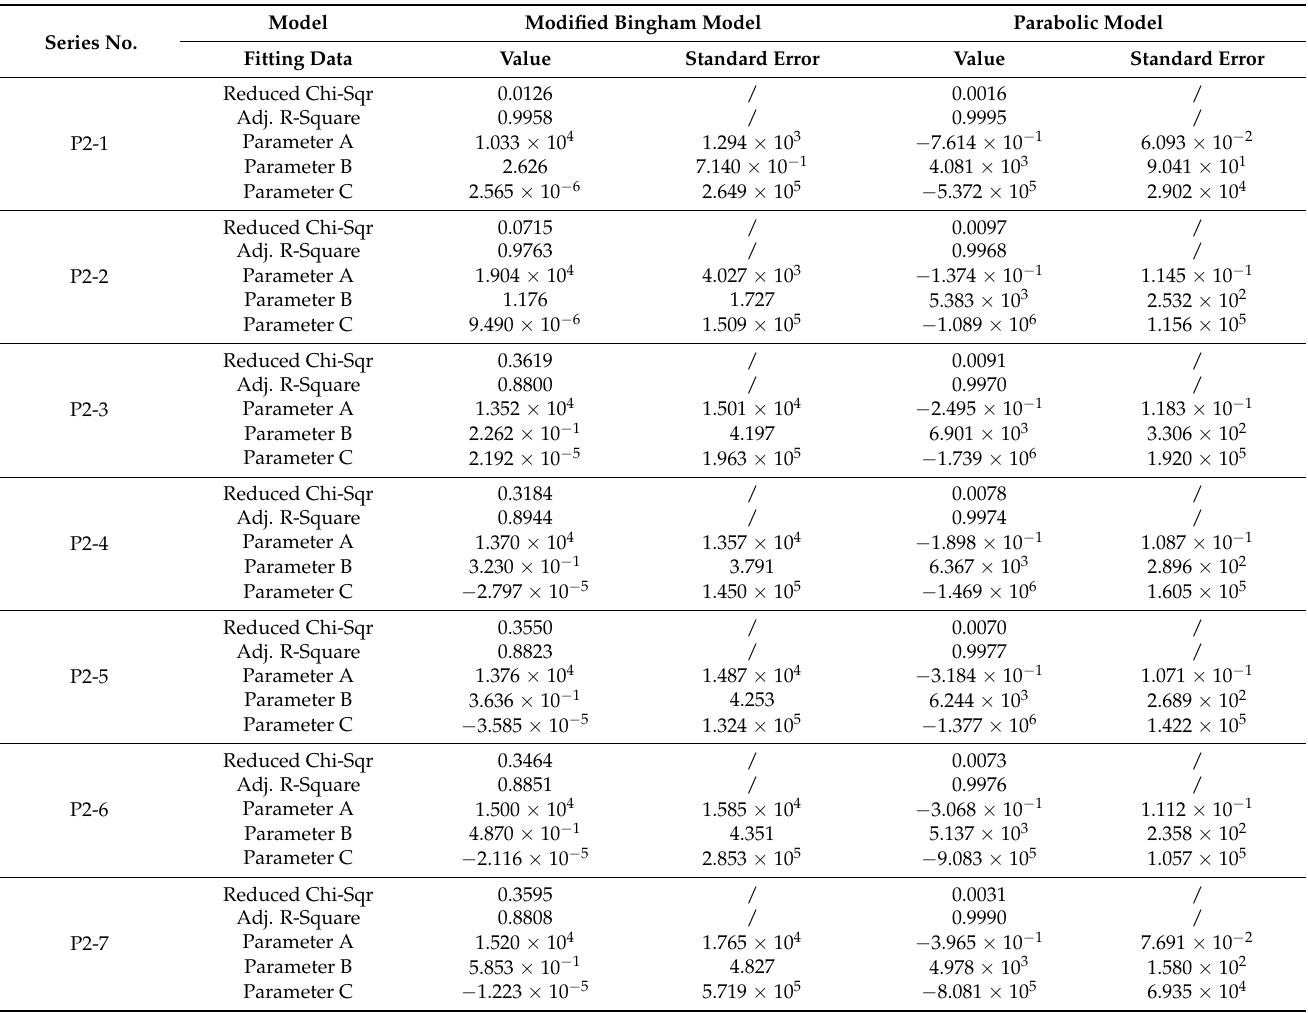
Table 4. Fitting data of P2 based on modified Bingham model and parabolic